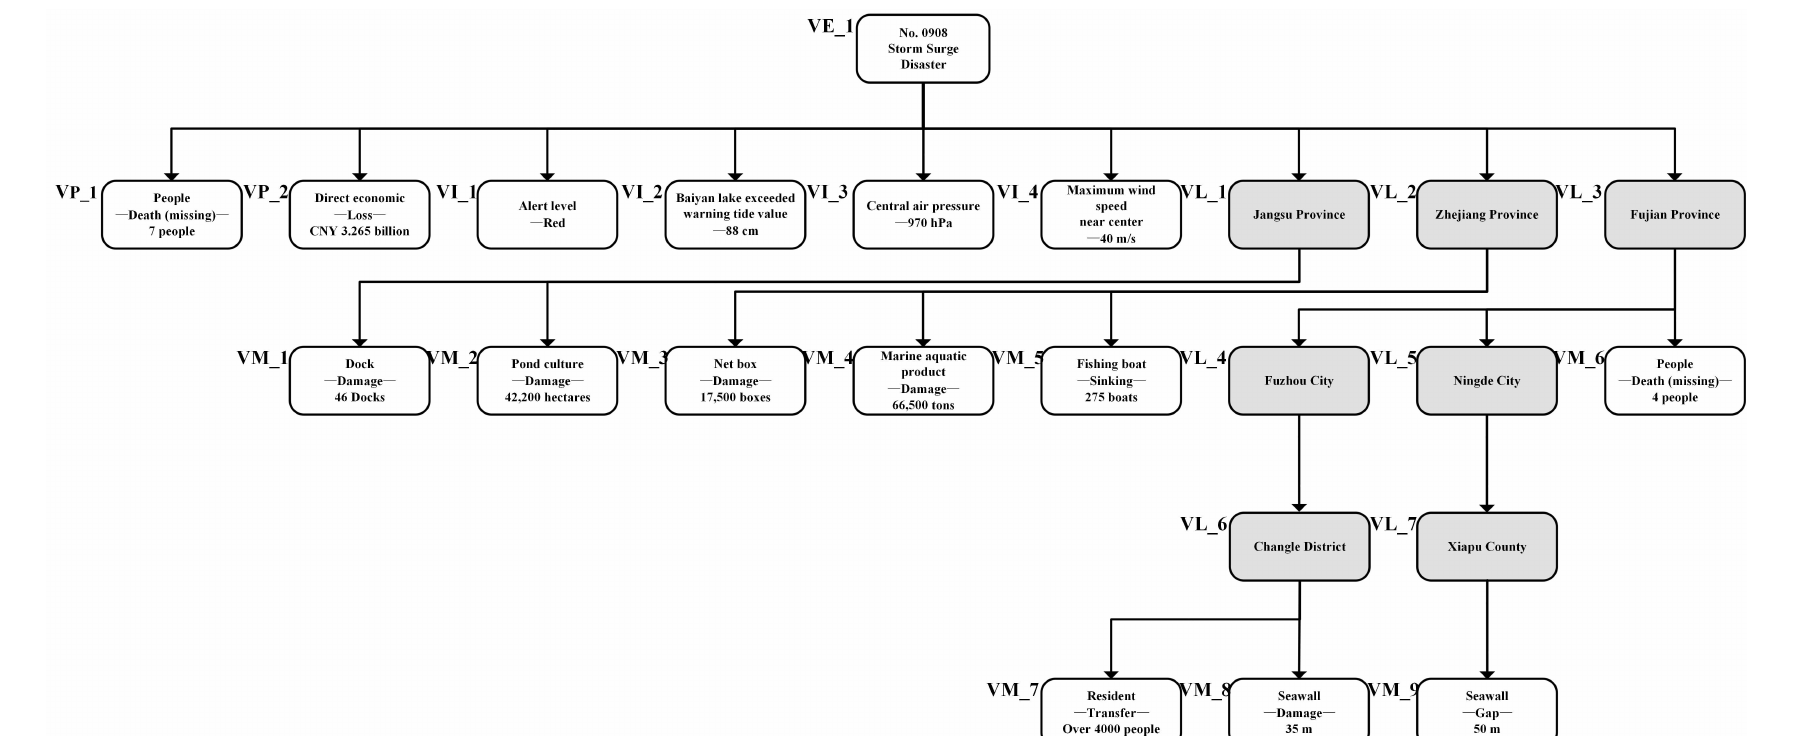
Figure 6. Sample of storm surge hazard case